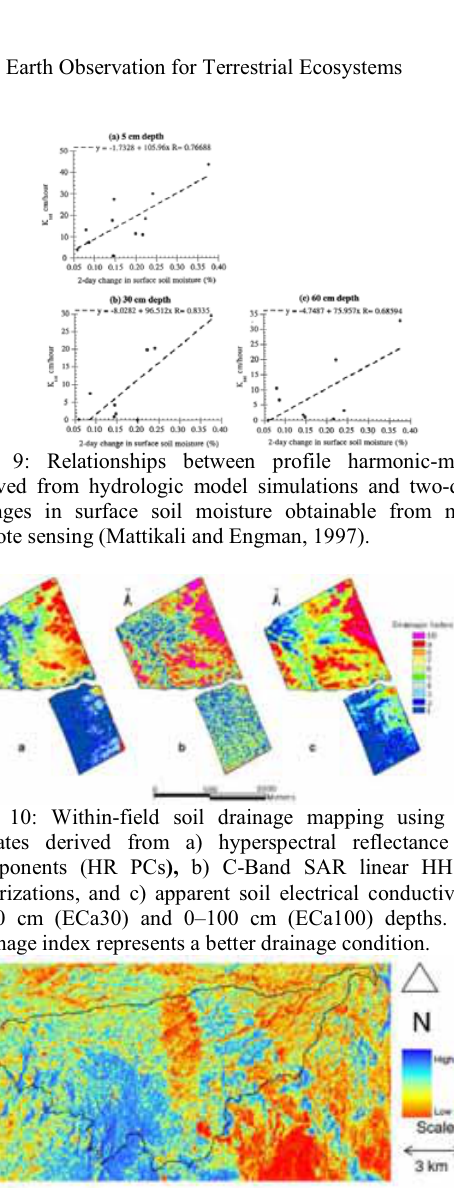
Fig 11: Roughness map (h RMS in cm) derived from radar images by the use of IEM, as formulated in Eq. (4). The solid line represents the boundary of USDA ARS Walnut Gulch Experimental Watershed (Rehman et al 2008).